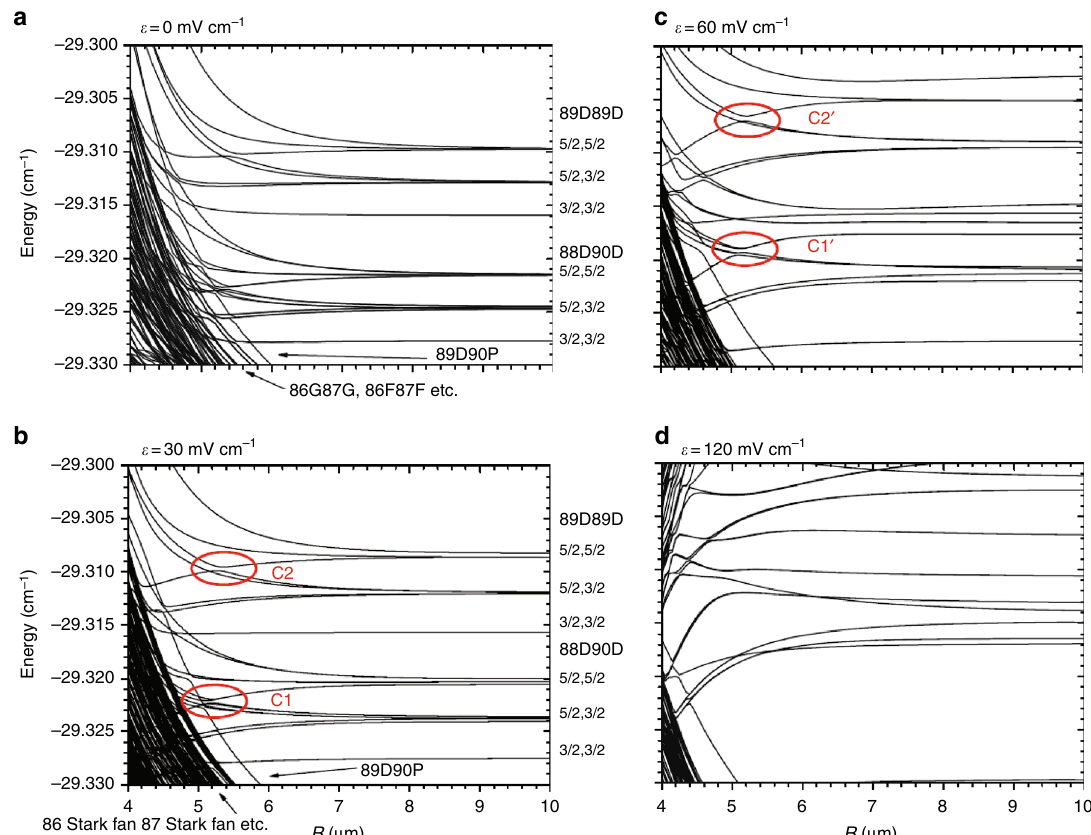
Fig. 4 Cs Rydberg macrodimer BO potential energy curves. The Cs Rydberg macrodimer potentials in the region of the 89 d + 89 d asymptote in the presence of an electric fi eld, ε . The total electronic angular momentum projection quantum number is m = 3. The electric fi eld lies along the internuclear axis. Some potential energy curve crossings that support bound states are labeled, C 1, C 2, C 1 ′ , and C 2 ′ . The labels along the vertical axes give the angular momentum j for each atom of the pair. The potential energy curves are shown for 0 mV cm − 1 ( a ), 30 mV cm − 1 ( b ), 60 mV cm − 1 ( c ) and 120 mV cm − 1 ( d ). Figure from ref. 19 , reprinted with permission from Taylor & Francis